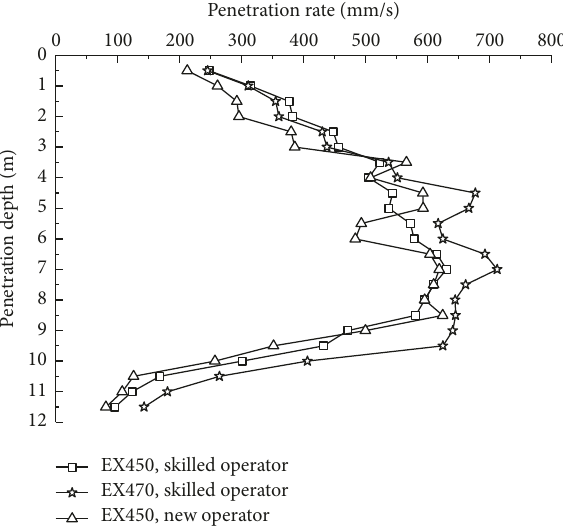
Figure 12: Penetration rate of piles driven in different sites versus penetration